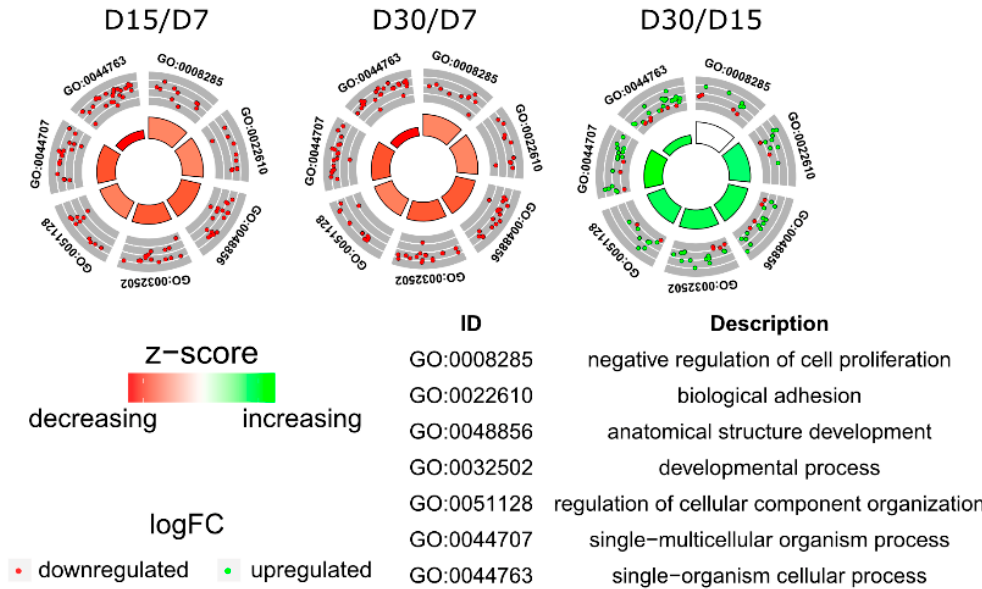
Figure 3. The circle plot showing the differently expressed genes and z-score of the anatomical structure development, biological adhesion, developmental process, negative regulation of cell proliferation, regulation of cellular component organization, single − multicellular organism process, and single − organism cellular process GO BP terms. The outer circle shows a scatter plot for each term of the fold change of the assigned genes. Green circles display upregulation and red ones downregulation. The inner circle shows the z-score of each GO BP term. The width of each bar corresponds to the number of genes within GO BP term and the color corresponds to the z-score.